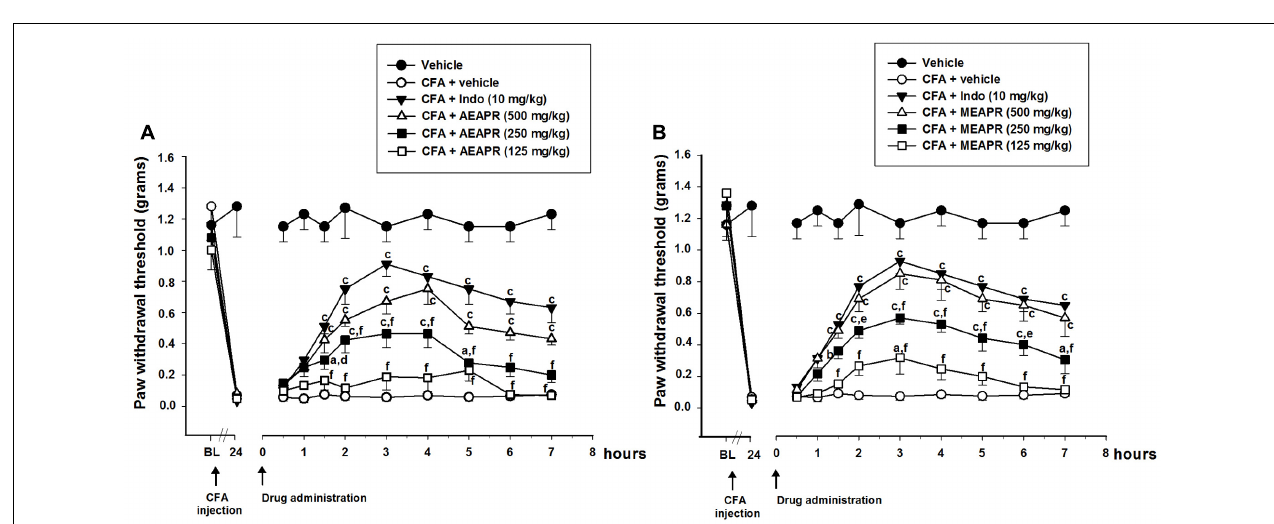
FIGURE 3 | Effect of acute administration of AEAPR (A) and MEAPR (B) on mechanical hypersensitivity in mice. Animals (six mice each group) were treated orally with vehicle (distilled water), indomethacin (Indo), MEAPR or AEAPR (125, 250, and 500 mg/kg), 24 h after intraplantar injection of Complete Freund’s adjuvant (CFA; 20 µ l). Each point represents the mean ± SEM of the paw withdrawal threshold (in grams) to hind paw stimulation, before (basal level: BL), 24 h after the injection of CFA (time 24 h) and at the times indicated after drug administration. a p < 0.05, b p < 0.01 and c p < 0.001 in comparison with CFA + vehicle treated group; d p < 0.05; e p < 0.01 and f p < 0.001 in comparison with CFA + indomethacin treated group, using Holm–Sidak post hoc